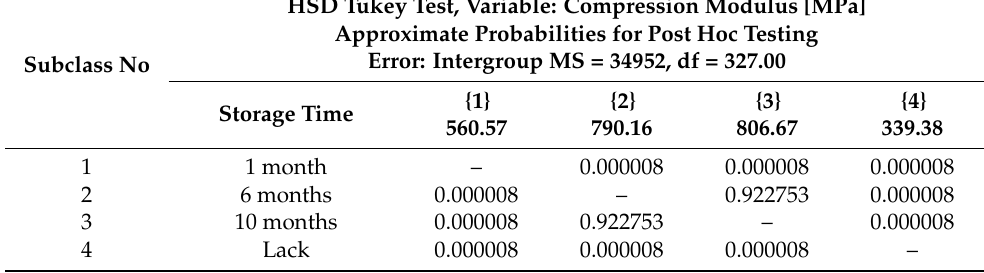
Table 6. Significant differences between the results sorted by aging duration.